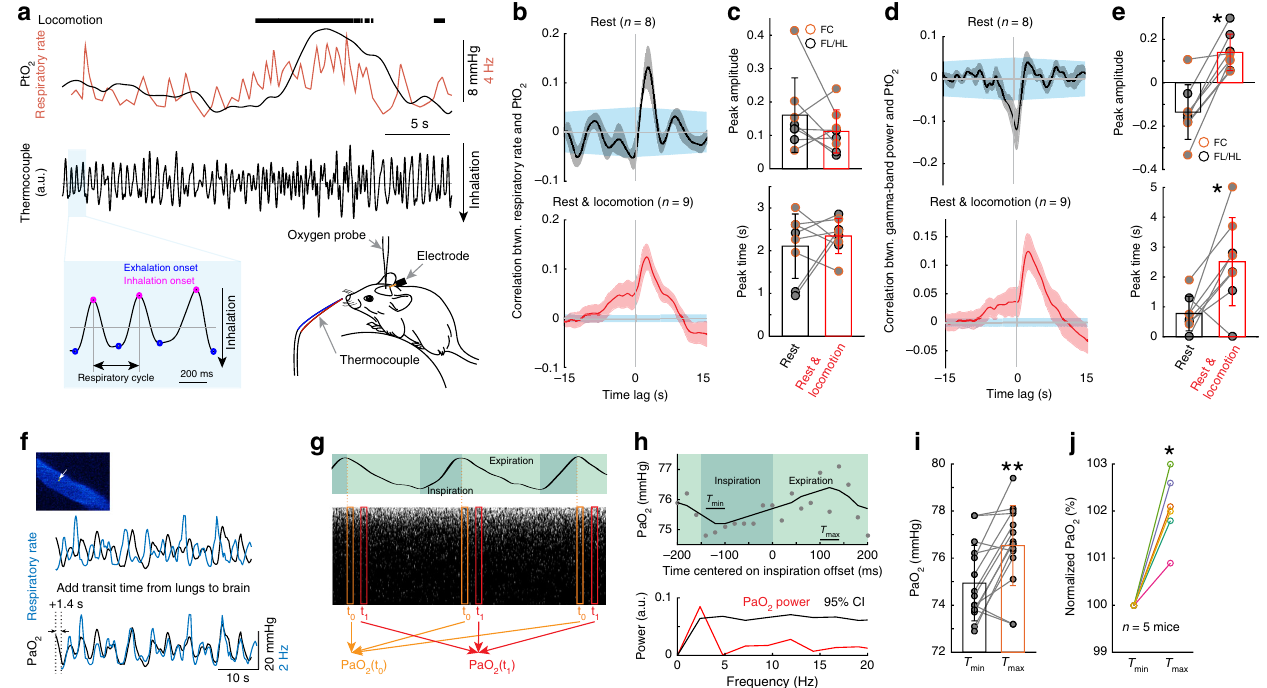
Fig. 4 Respiration drives changes in cerebral tissue and arterial blood oxygenation. a Measuring respiration using a thermocouple. b Cross-correlation between PtO 2 and respiratory rate during rest (top) and periods including rest and locomotion (bottom). c Peak amplitude (top, Wilcoxon signed-rank test, p = 0.3125) and peak time delay (bottom, Wilcoxon signed-rank test, p = 0.7422) of cross-correlation between PtO 2 and respiratory rate during rest (black) and periods including rest and locomotion (red). d As ( b ) but for correlation between PtO 2 and gamma-band LFP power. e As ( c ) but for peak time (* paired t -test, t (7) = 6.1918, p < 0.001) and peak time delay (* Wilcoxon signed-rank test, p = 0.0234) of cross-correlation between PtO 2 and gamma- band LFP power. f Example data showing the temporal relationship between respiratory rate (black) and PaO 2 (blue) in the center of one artery (white arrow) in somatosensory cortex during rest. g Schematic showing measurement of PaO 2 fl uctuations driven by respiration cycle. h Top, PaO 2 change in one artery during the respiratory cycle at rest. Each fi lled circle denotes averaged PaO 2 over a 20 ms window aligned to a speci fi c phase of the respiration cycle and averaged over 15 recordings. The solid curve shows fi ltered data ( fi rst-order binomial fi lter, fi ve repetitions). T min and T max denote the time period (40 ms) PaO 2 reaches minimum and maximum, respectively. Bottom, power spectrum of PaO 2 (red) and 95% con fi dence interval (CI, black) given by randomizing the phase of the PaO 2 signal. The PaO 2 power at the respiratory frequency (~2.5Hz) is signi fi cantly greater than the 95% CI level. i PaO 2 at T T p < 0.01. j Normalized PaO T T max and min for the 15 recordings from the artery shown in ( h ). ** Wilcoxon signed-rank test, 2 at min and max for six vessels (three in cortex, and three in olfactory bulb, n = 5 mice) with statistically signi fi cant PaO 2 power spectrum peaks at the respiratory frequency. * Wilcoxon signed-rank test, p = 0.0313. Data are shown as mean ± SEM in ( b ) and ( d ), and± SD in all other graphs. Blue shaded region in ( b ) and ( d ) shows 95% CI of